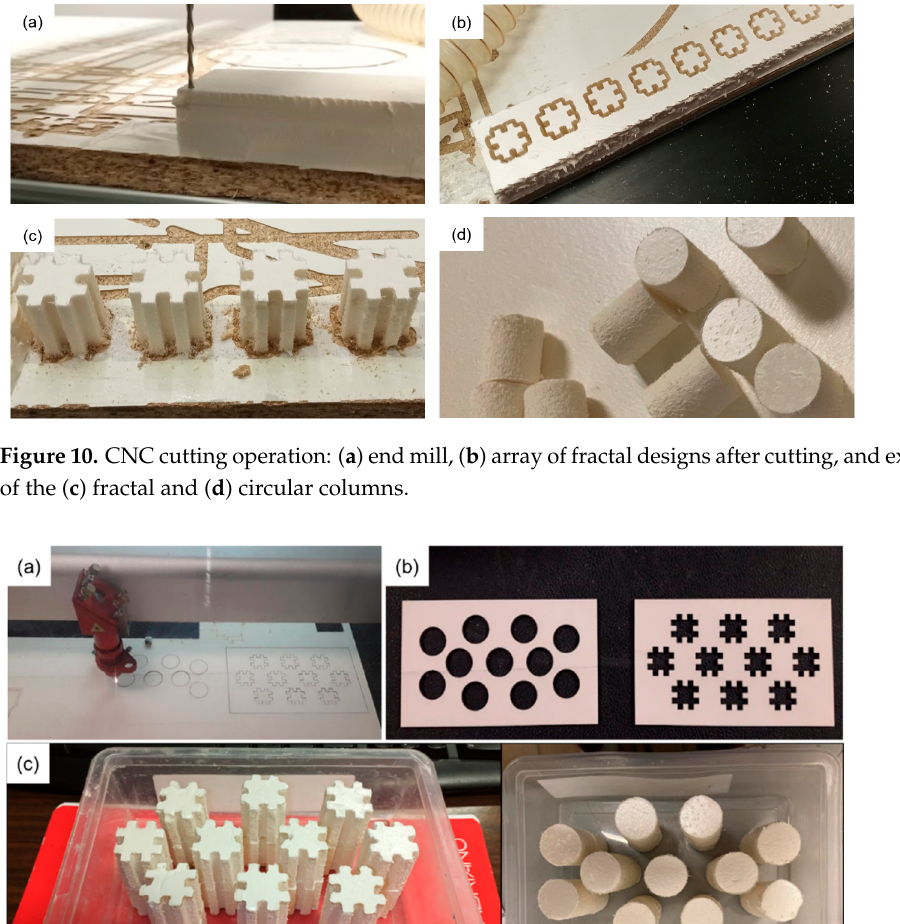
Table 9 . Cutting parameters selected for CNC cutting of high-density polystyrene columns.